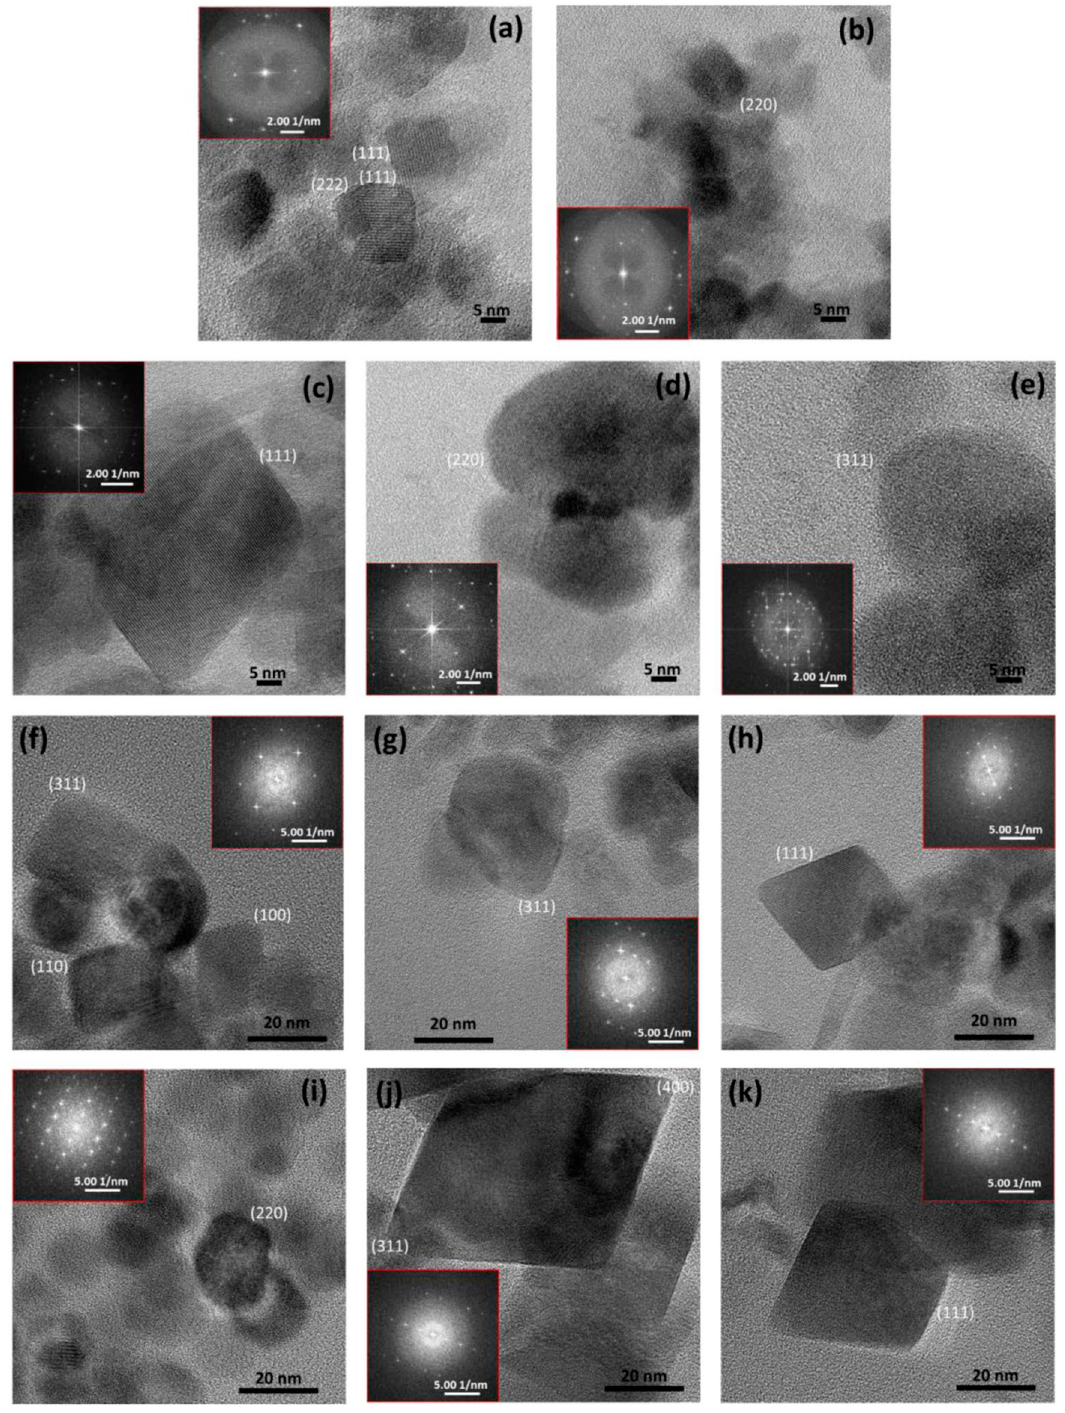
Figure 6. HRTEM images of different NPs: ( a , b ) inorganic magnetite NPs, ( c – e ) MamC magnetite NPs, ( f – h ) Mms6 magnetite NPs, and ( i – k ) Mms6-MamC-mediated NPs. Selected areas of electron diffraction are shown for each sample. (Reprinted from [32], license CC BY 4.0.)